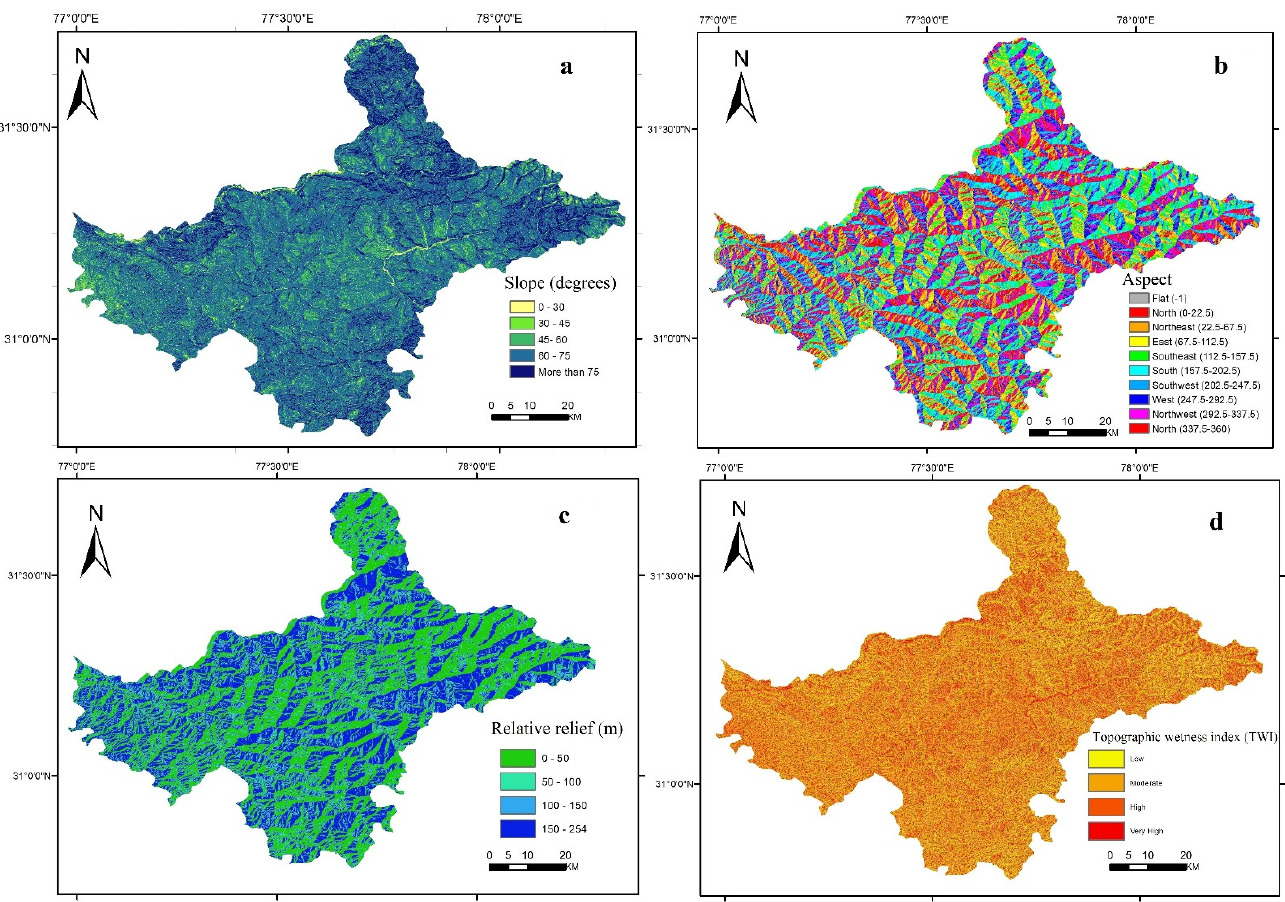
Figure 2. Causative factors: ( a ) Slope gradient ( b ) Slope aspect ( c ) Relative relief ( d ) Topographic wetness index.